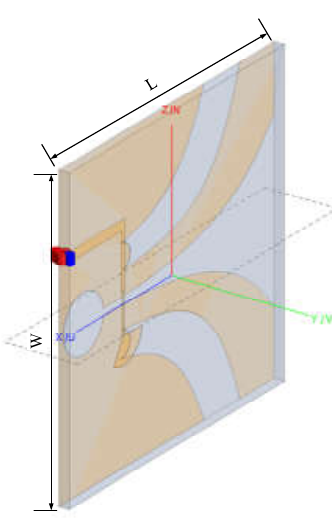
Figure 8. Vivaldi antenna